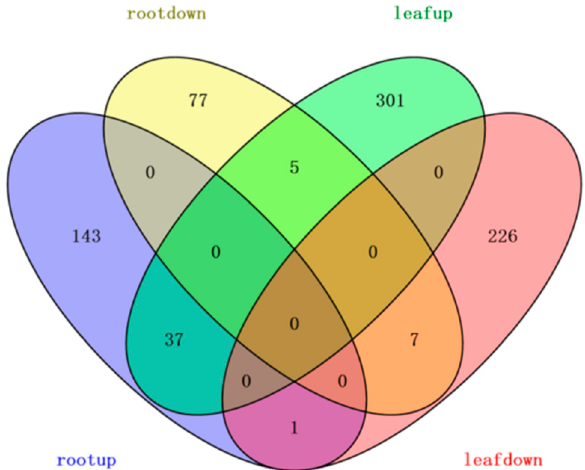
Figure 2. Venn diagram of differentially expressed proteins identified at three different treatment time points.